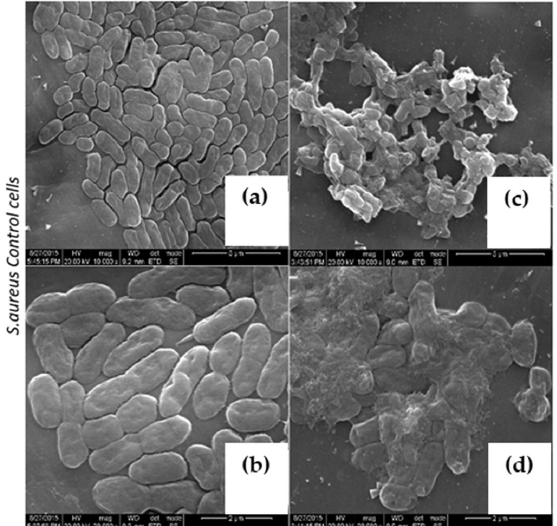
Figure 6. Characteristic morphological changes on S. aureus. ( a , b ) Untreated cells. ( c ) Treated with LBP at Sub MIC (30 µ g/mL) ( d ) Treated with LBP at Sup MIC (60 µ g/mL).